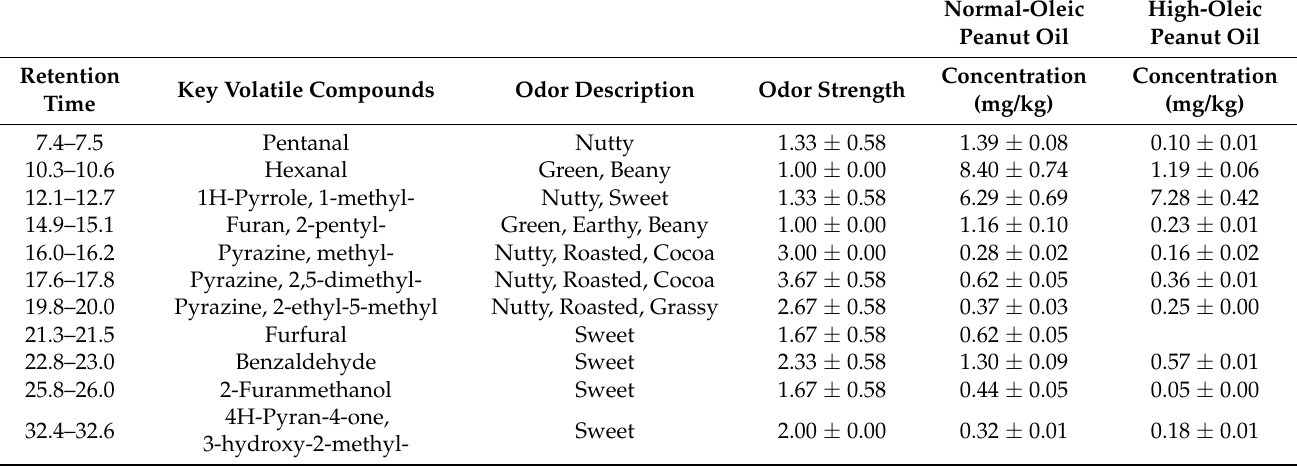
Table 3. Odor strength and relative concentration of key volatile components in normal- and high-oleic peanut oil.